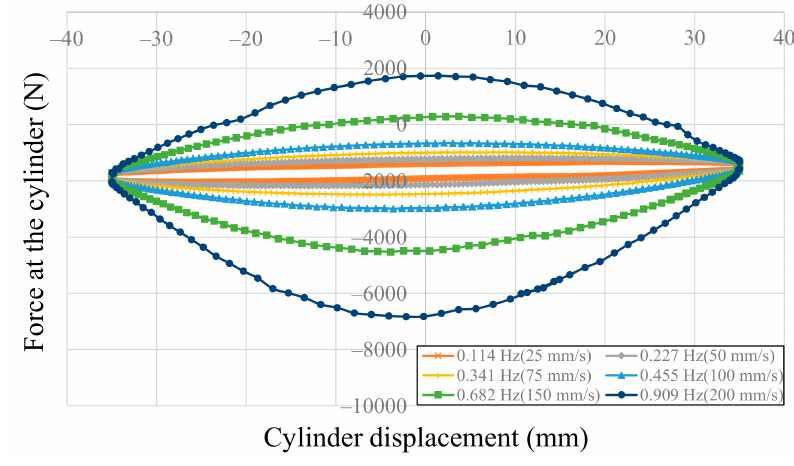
Figure 12. Force-velocity results from test when applied valve current was 720 mA (command 40%).